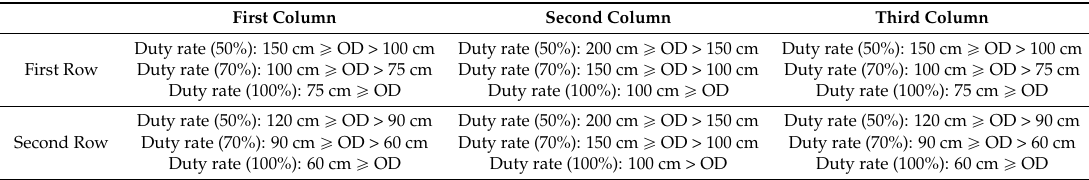
Table 1. Duty rate of vibration motor according to obstacle distance (OD). First Column Second Column Third